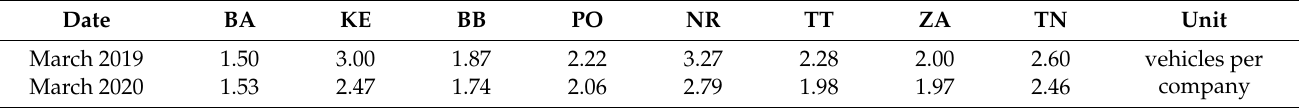
Table 5. Average number of vehicles per one taxi company. Source: processed by authors.